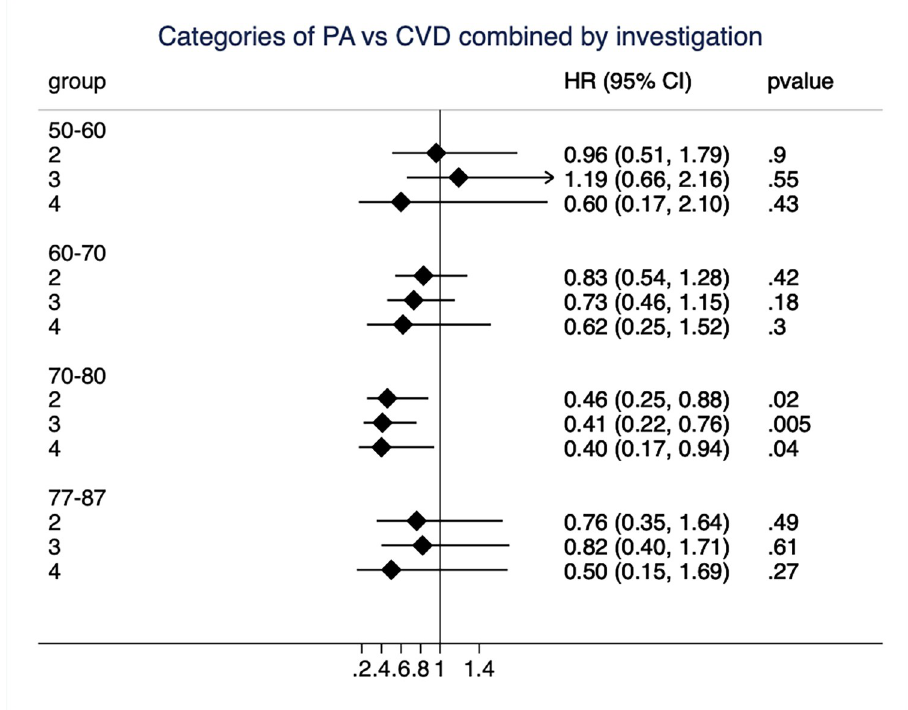
Fig 4. Hazard ratio (HR) and 95%CI for of physical activity (PA) when groups 2 to 4 were compared to the reference group one (sedentary) for the combined end-point of cardiovascular disease (CVD) when the 10-year risk was calculated among men free of previous CVD from each of the four investigation cycles in the ULSAM- cohort (performed at ages 50, 60, 70 and 77 years). MI, myocardial infarction; HF, heart failure.